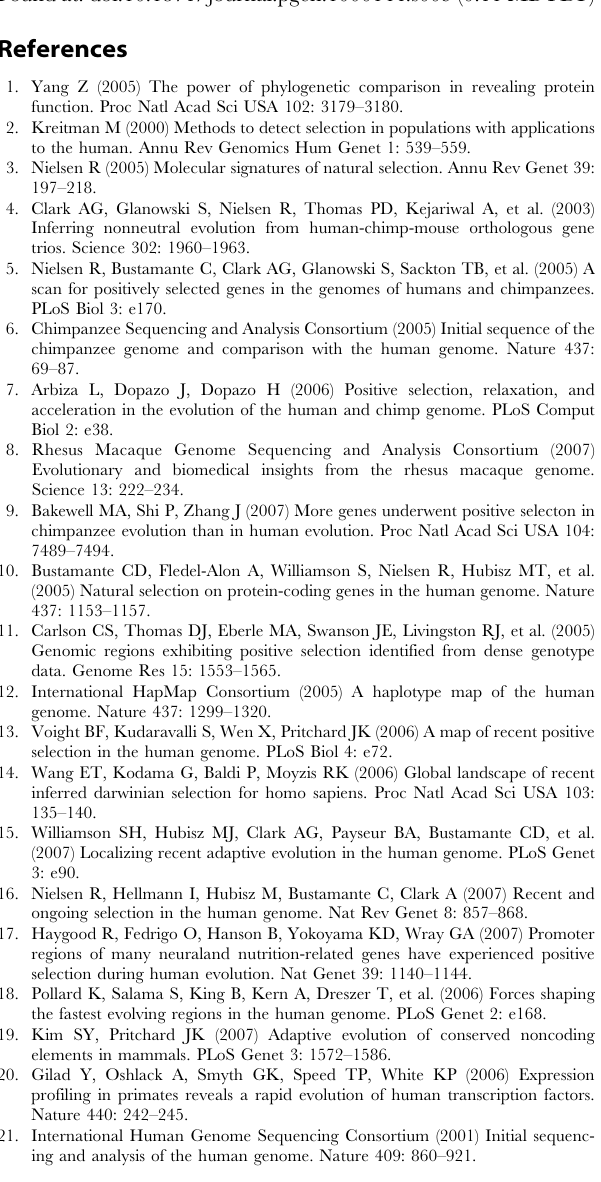
Figure S5 p53 signaling pathway. Figure S6 GO similarity. Found at: doi:10.1371/journal.pgen.1000144.s006 (0.29 MB TIF) Figure S7 Expression results for all tissues. Found at: doi:10.1371/journal.pgen.1000144.s007 (0.50 MB TIF) Table S1 Minimum species configurations required for likeli- hood ratio tests. Table S2 GO categories over-represented among predicted PSGs.